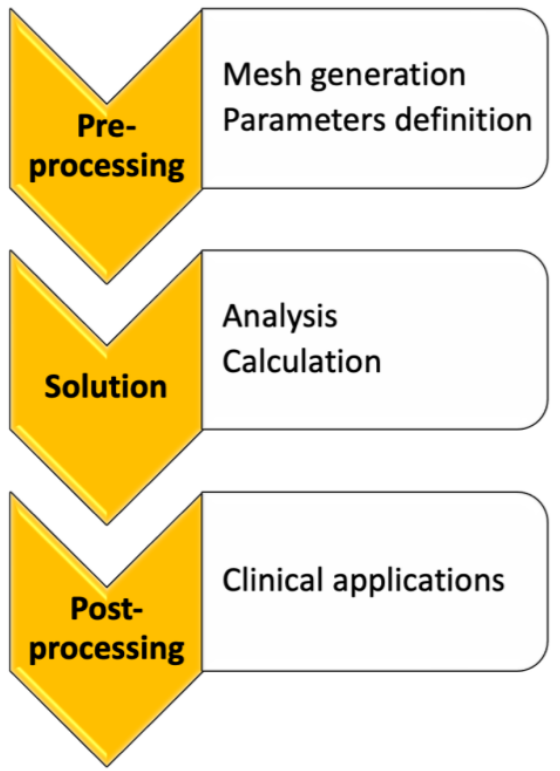
Figure 1. Schematic representation of simulation methodology.